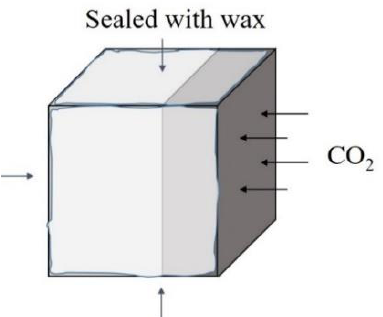
Figure 3. Direction of CO 2 diffusion during carbonation.